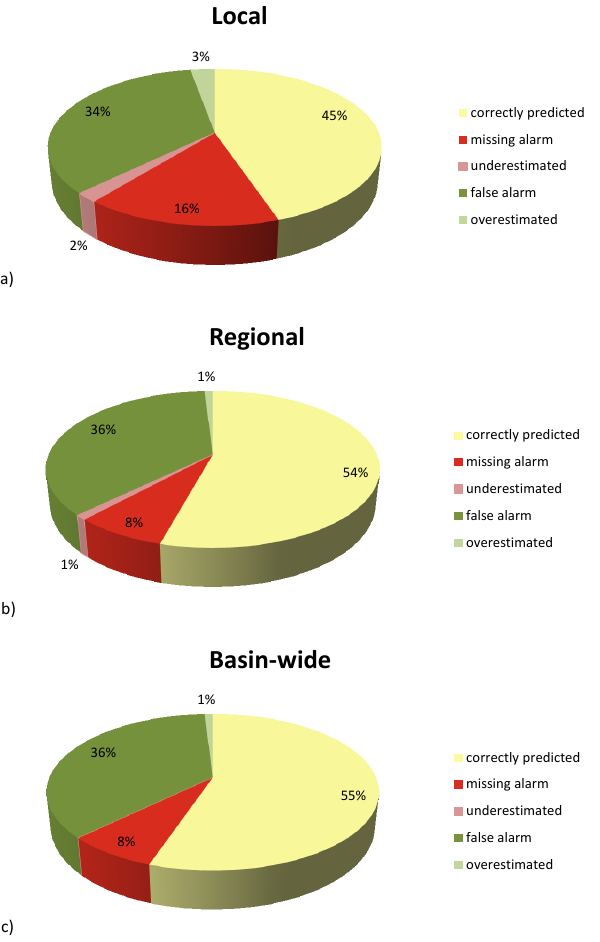
Fig. 3. Performance of the DM at local (a) , regional (b) and basin- wide (c) level. The number of underestimated events is obtained by summing up all the out-of-diagonal values of the DM with 0 < i < k , while the number of missing alarms is the sum of the values of the DM with i = 0 and i <k . Analogously, the number of overestimated events is obtained by summing up all the out-of-diagonal values of the DM with 0 < k < i and the false alarms are given by the sum of the values with k = 0 and i >k .